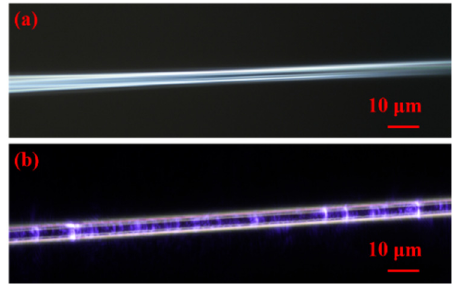
Figure 2. ( a ) tapered fiber; ( b ) GDY-SA: Graphdiyne-modified tapered fiber.